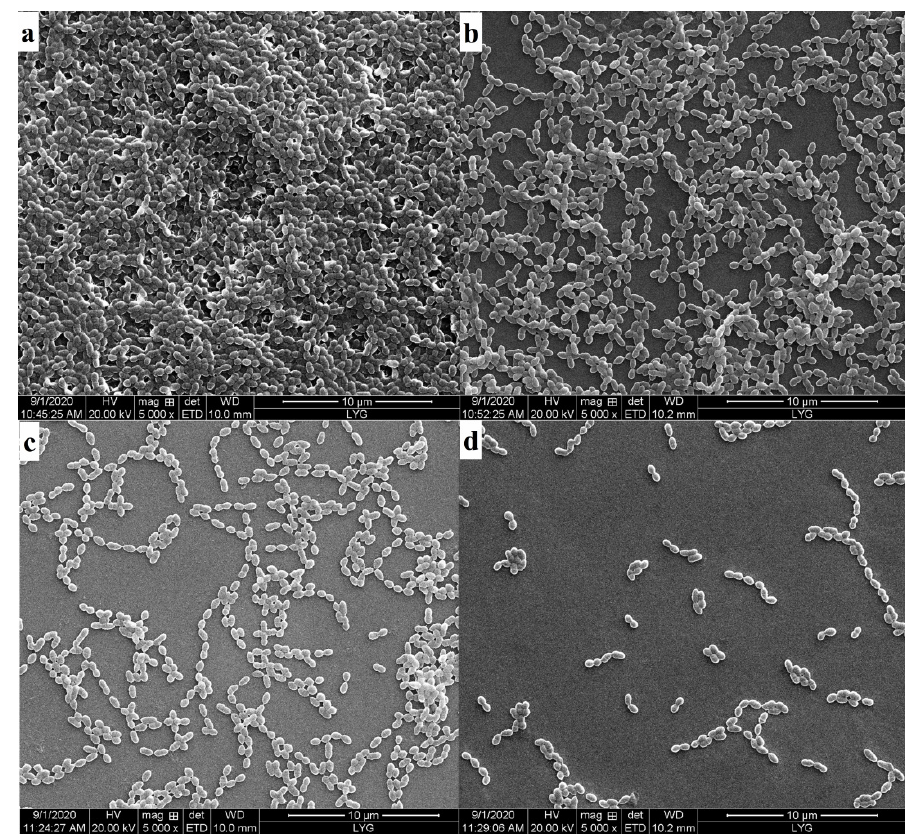
Figure 6. ( a ) Control group (add pure water); ( b ) add free enzyme (3.6 U); ( c ) add HA (10 mg); and ( d ) add immobilized enzyme (10 mg HA immobilized 3.6 U of free enzyme).